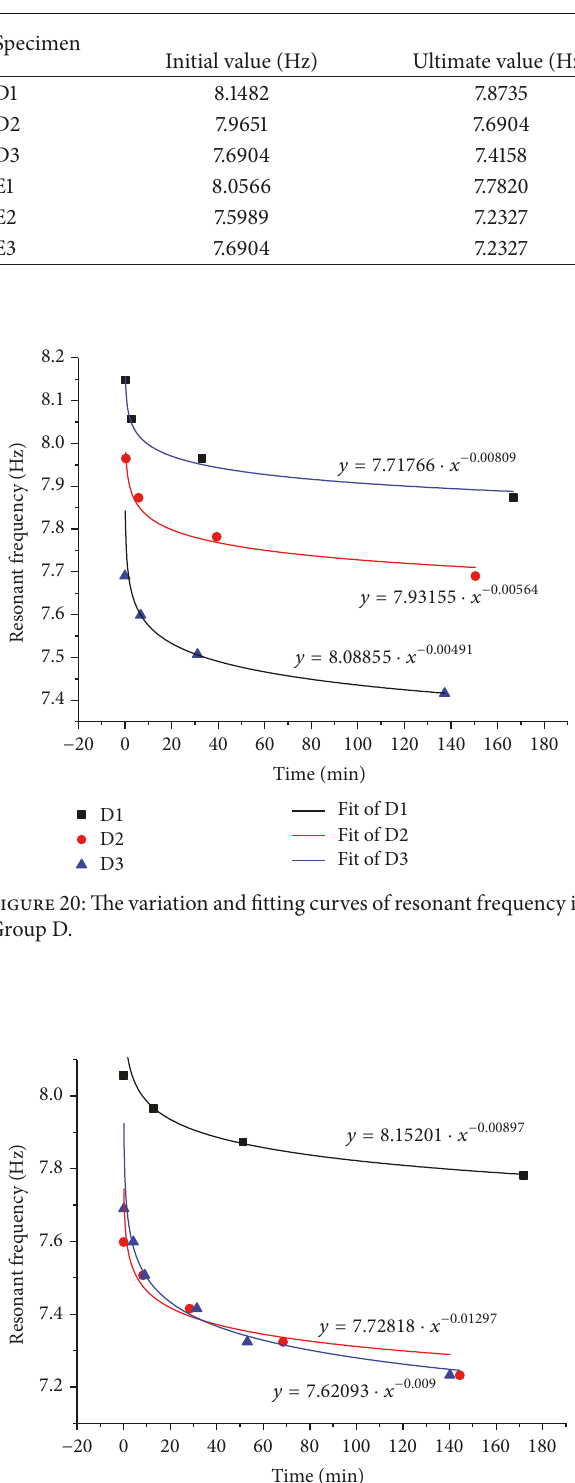
Table 7: The test result of Group D&E.